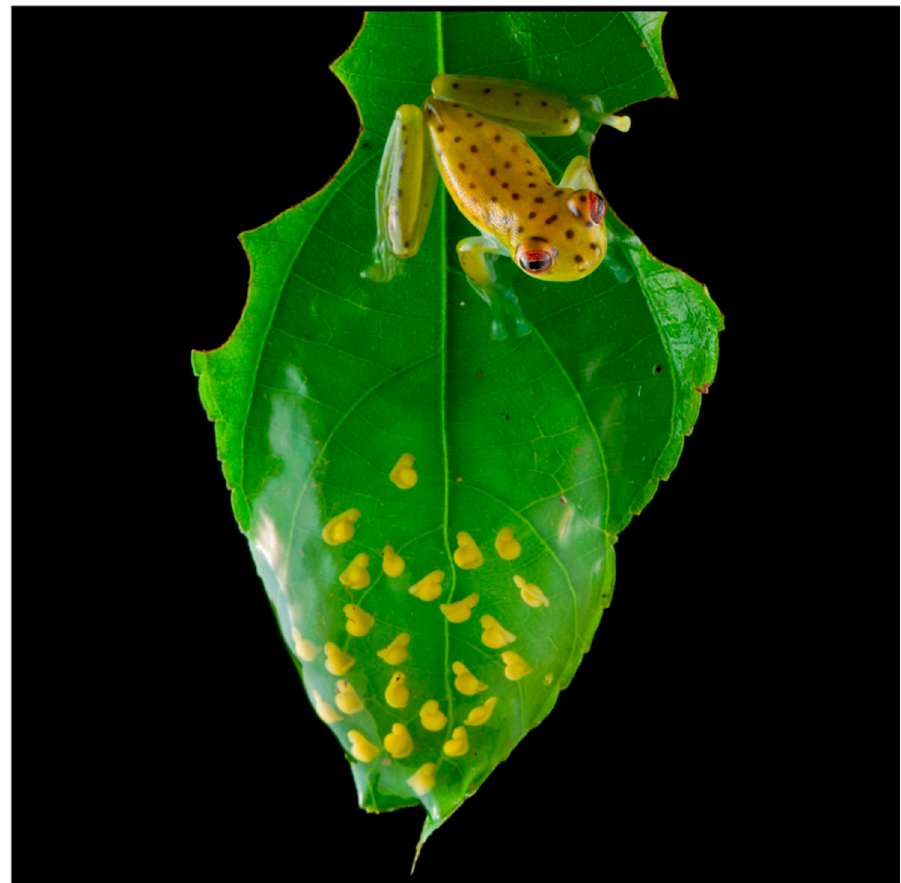
Figure 71. Cochranella litoralis in life. Male from Tundaloma Lodge (1.182 N, 78.749 W; 74 m), Esmeraldas province, Ecuador (3 January, 2014; not collected). Photo by Lucas Bustamante/Tropical